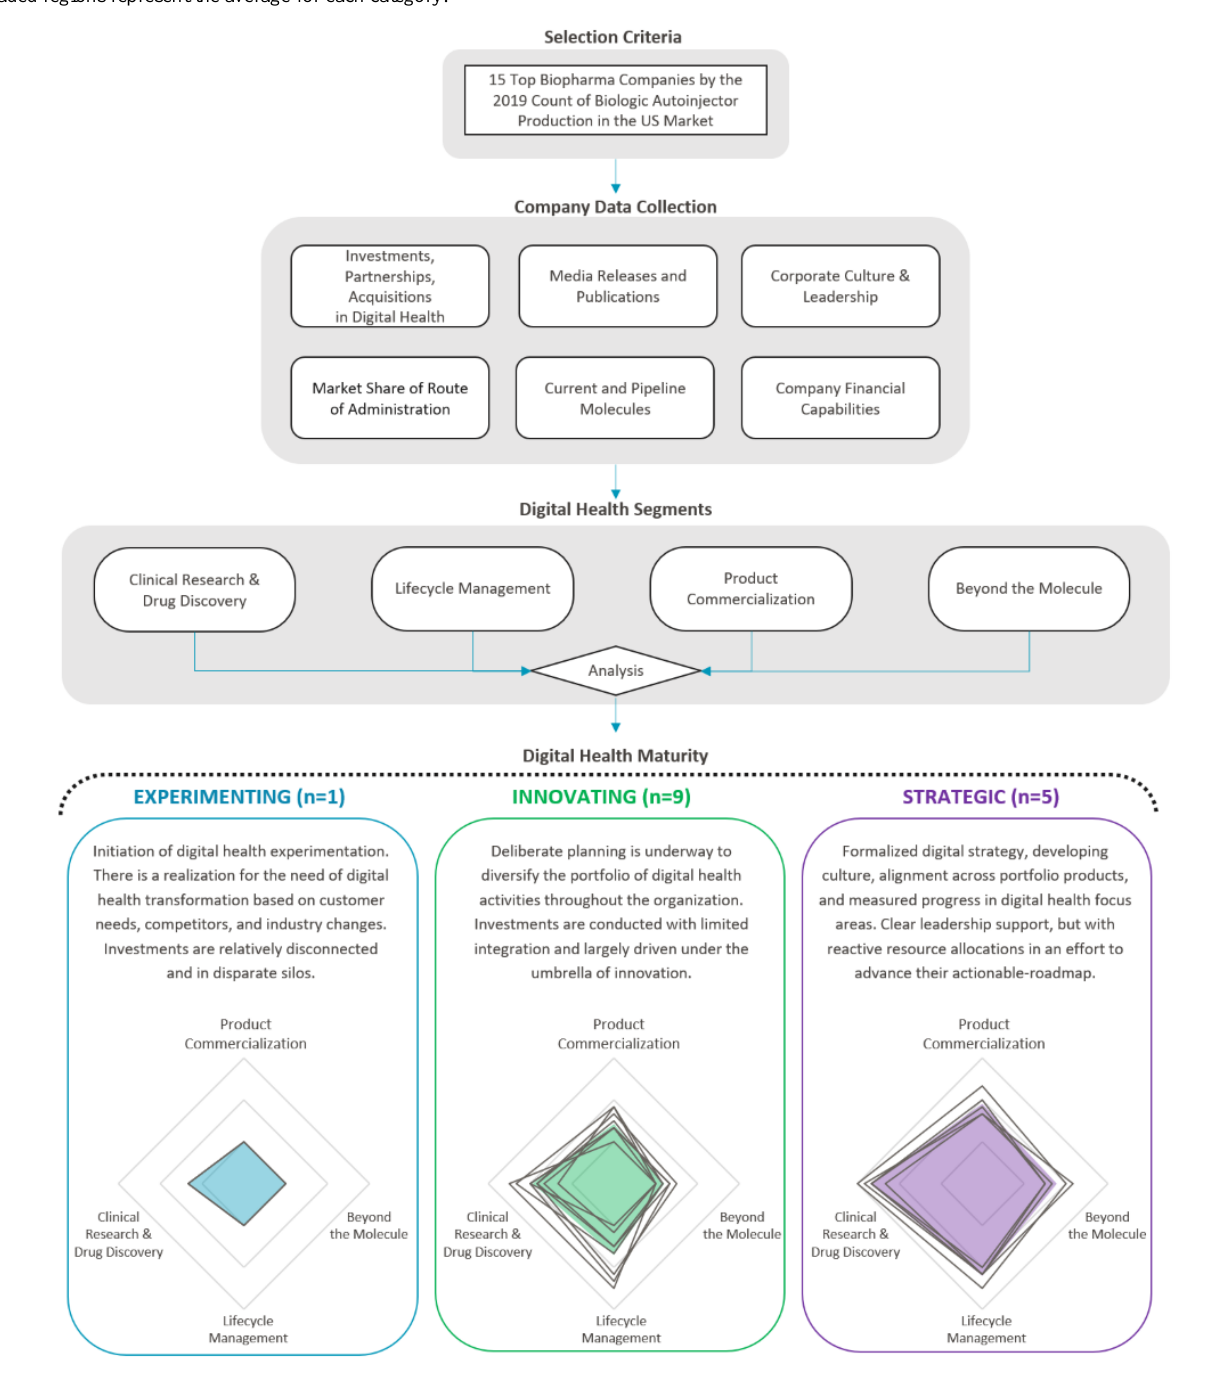
Figure 1. Framework for biopharma digital maturity assessment. This figure demonstrates biopharma’s overall approach toward digital health based on a segmentation analysis covering clinical research and drug discovery, lifecycle management, product commercialization, and beyond the molecule. Companies were classified within three distinct digital health maturity categories. Radar charts show individual company ratings for each segment, and shaded regions represent the average for each